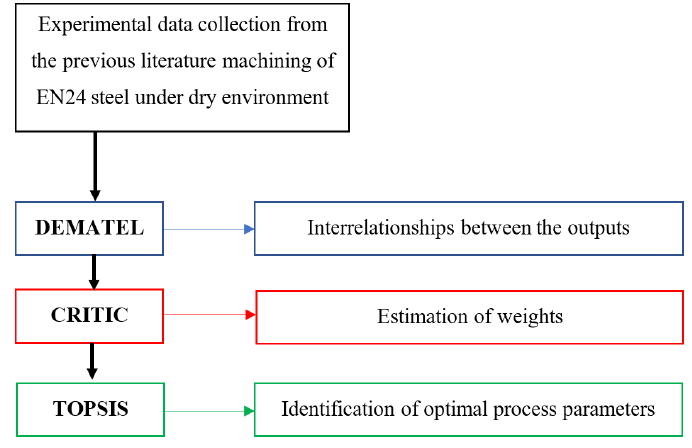
Fig. 1. Methodology